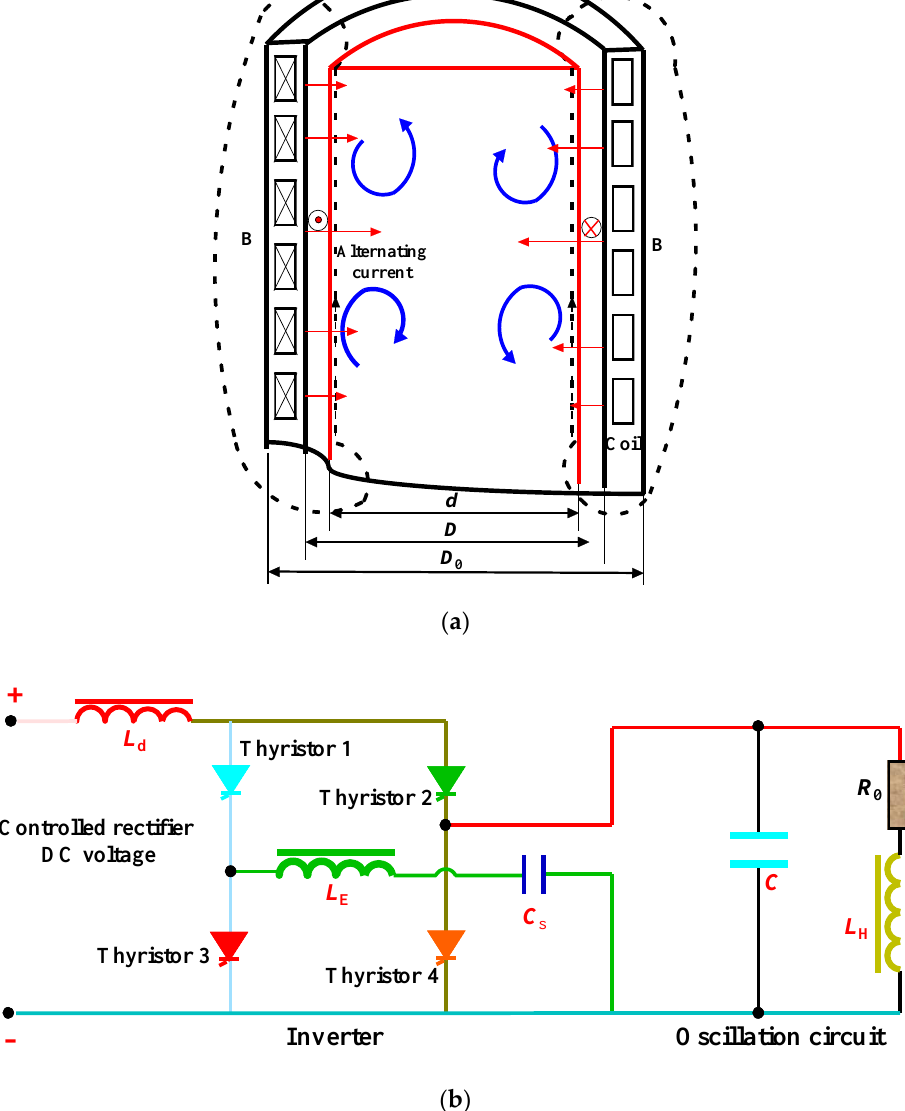
Figure 1. An intermediate-frequency induction furnace with inverter circuit of hybrid power supply. ( a ) structure diagram of intermediate induction frequency furnace; ( b ) inverter circuit of hybrid power supply.